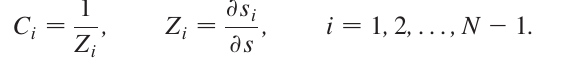
FIG. 3. The left plot presents the impact of global compression term Z 00 0 very strong compression in the head of the bunch can be seen. The right plot shows the current profiles for these compression scenarios.